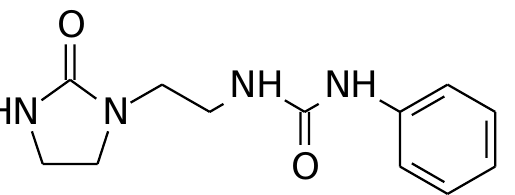
Figure 1. Ethylenediurea — N-[2-(2-oxo-l-imidazolidinyl)ethyl]-N ′ -phenyiurea